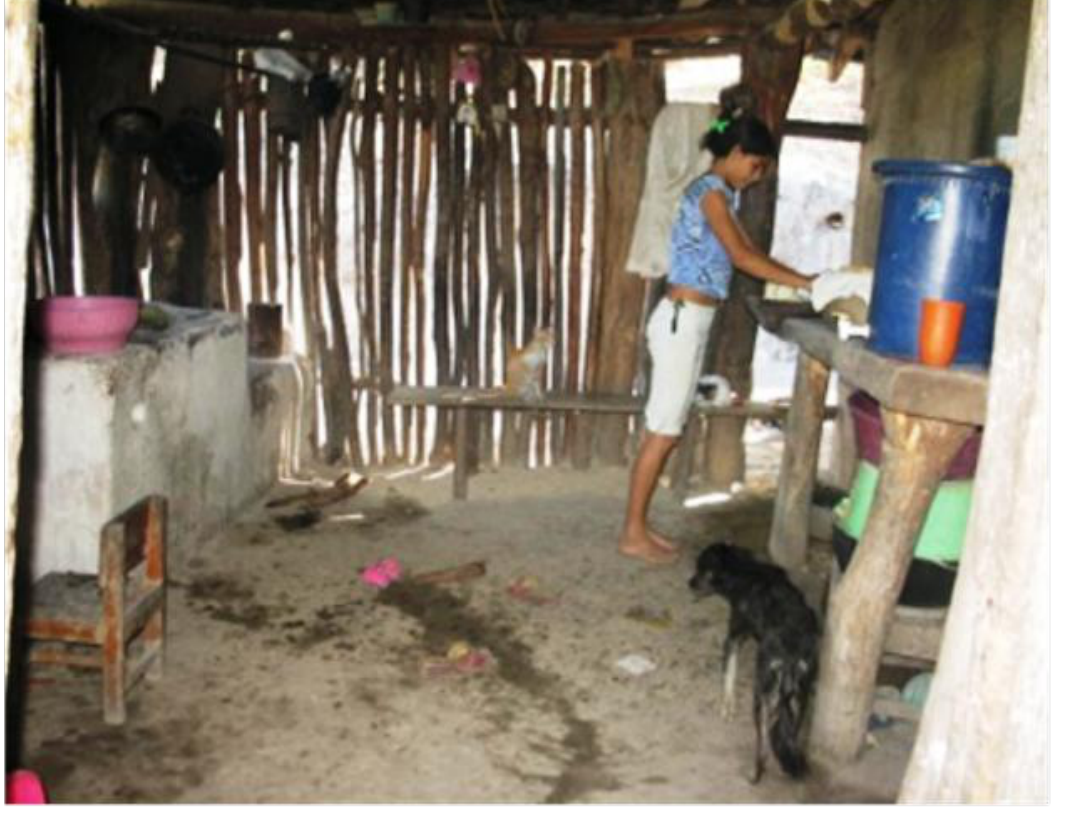
Note: Photo: Gilberto